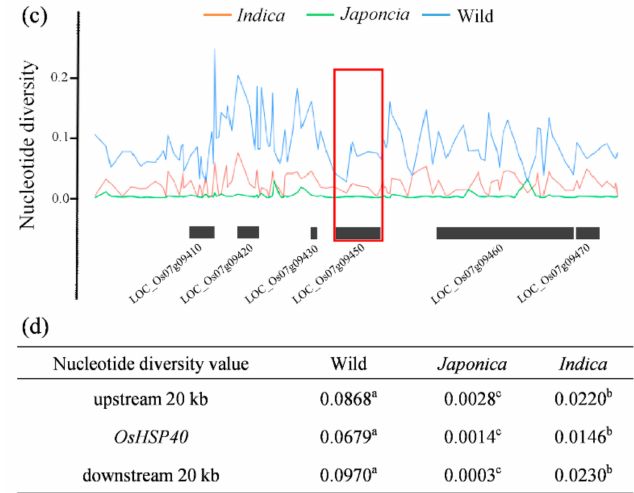
Figure 6. Functional SNP and nucleotide diversity analysis of OsHSP40. ( a ) The position of functional SNP in the CDS region of OsHSP40. ( b ) Comparisons of phenotype in the accessions with different functional SNPs of OsHSP40 . FLW, flag leaf width; PH, plant height; PL, panicle length; GL, grain length; GW, grain width; TGW, 1000-grain weight. ( c ) Nucleotide diversity of OsHSP40 in japonica , indica , and wild rice. Red box denotes the position of OsHSP40 . ( d ) Average nucleotide diversity of the 20 kb region surrounding OsHSP40 . The different letters indicate the significant differences determined using ANOVA test: p <